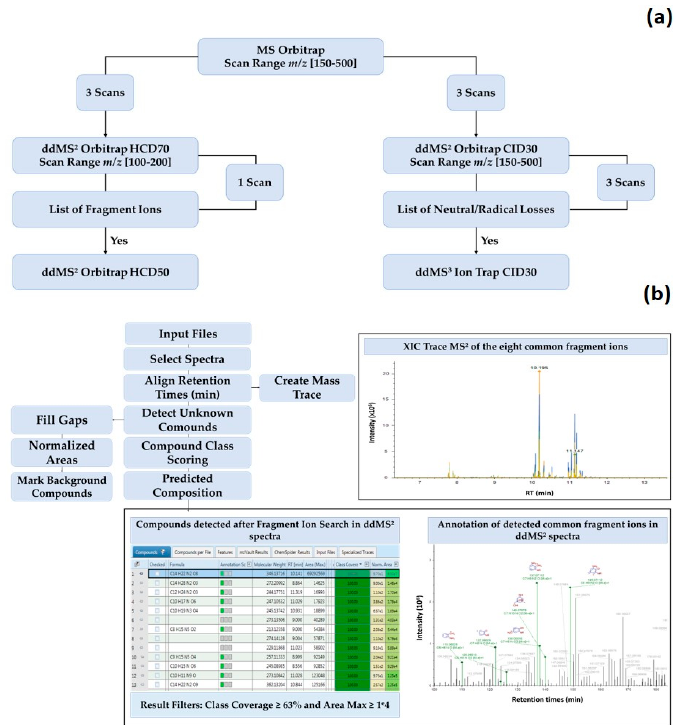
Figure 1. Flowchart of the developed untargeted screening approach of MAAs using an Orbitrap MS based on data-dependent MS 2 / MS 3 Acquisition ( a ). Untargeted workflow designed on Compound Discoverer TM to flag putative MAAs in algal extracts ( b ). Description of the role of the following nodes: Compound Class Scoring: Calculation of the percentage of common fragment ions detected in mass spectral data of every compound in the result table. Predicted Composition: Proposition of chemical formula for unknown compounds. Create mass Trace: Create mass chromatogram of compounds for which common fragment ions were detected in their mass spectral data. Fill Gaps: Indication of missing peaks or peaks below the detection threshold. Normalize Areas: Normalization of chromatographic peaks. Mark Background Compounds: Identification of compounds in